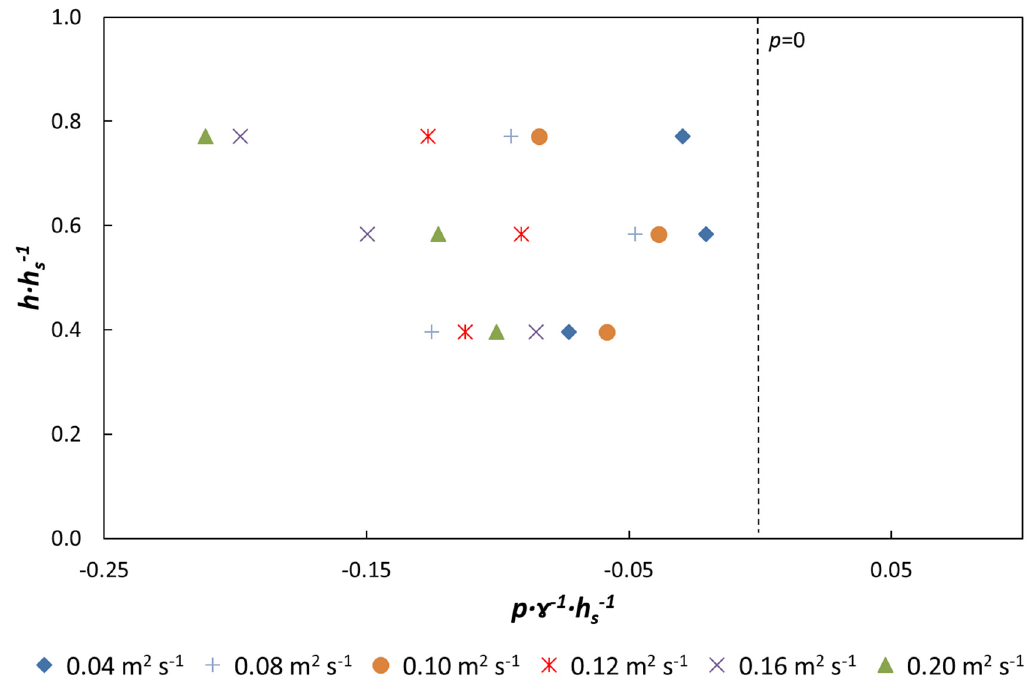
Figure 19. The average of the hydrodynamic pressures registered on the block riser of the Armorwedge TM block ( w 1) in row 25 of the chute for different unit discharges simulating the blocks laid over an impervious soil with an intermediate and permeable bedding granular layer ( d 2).